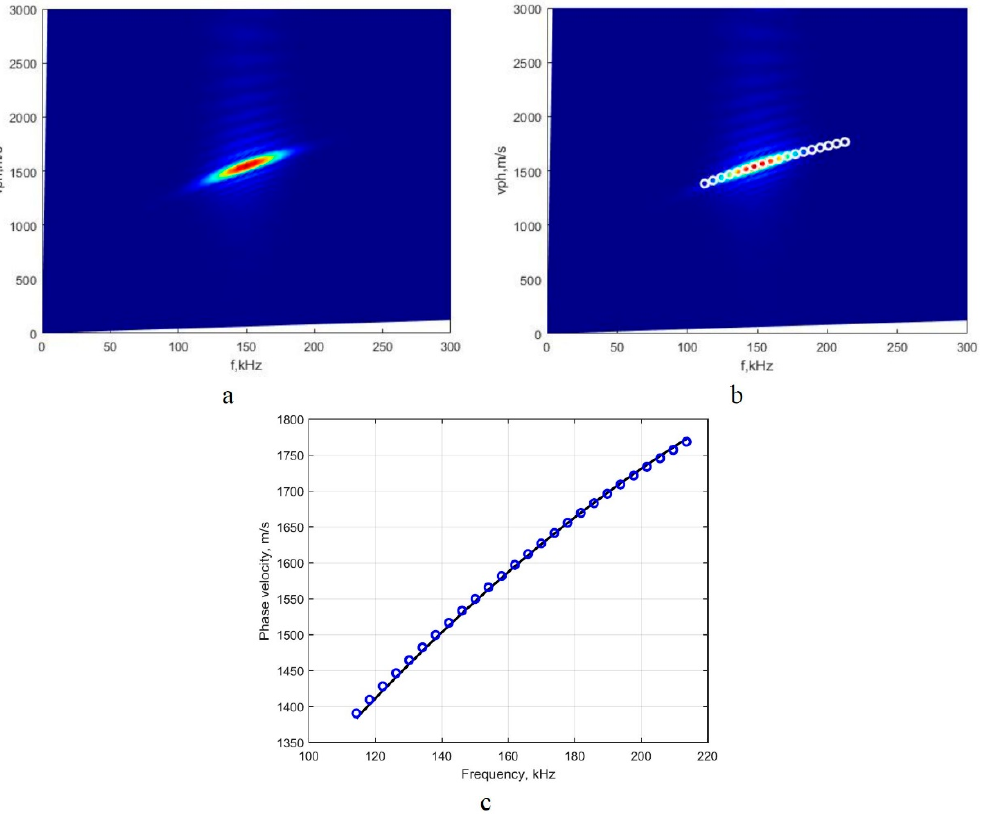
Figure 4. Image of the A 0 -mode phase-velocity dispersion curve segment obtained by 2D-FFT method ( a ); reconstructed quantitative values of the dispersion curves segment, using the proposed method ( b ); and the dispersion curve segment obtained by analytical method (package ‘DISPERSE’, the solid line) and reconstructed by using the proposed algorithm (circles) ( c )